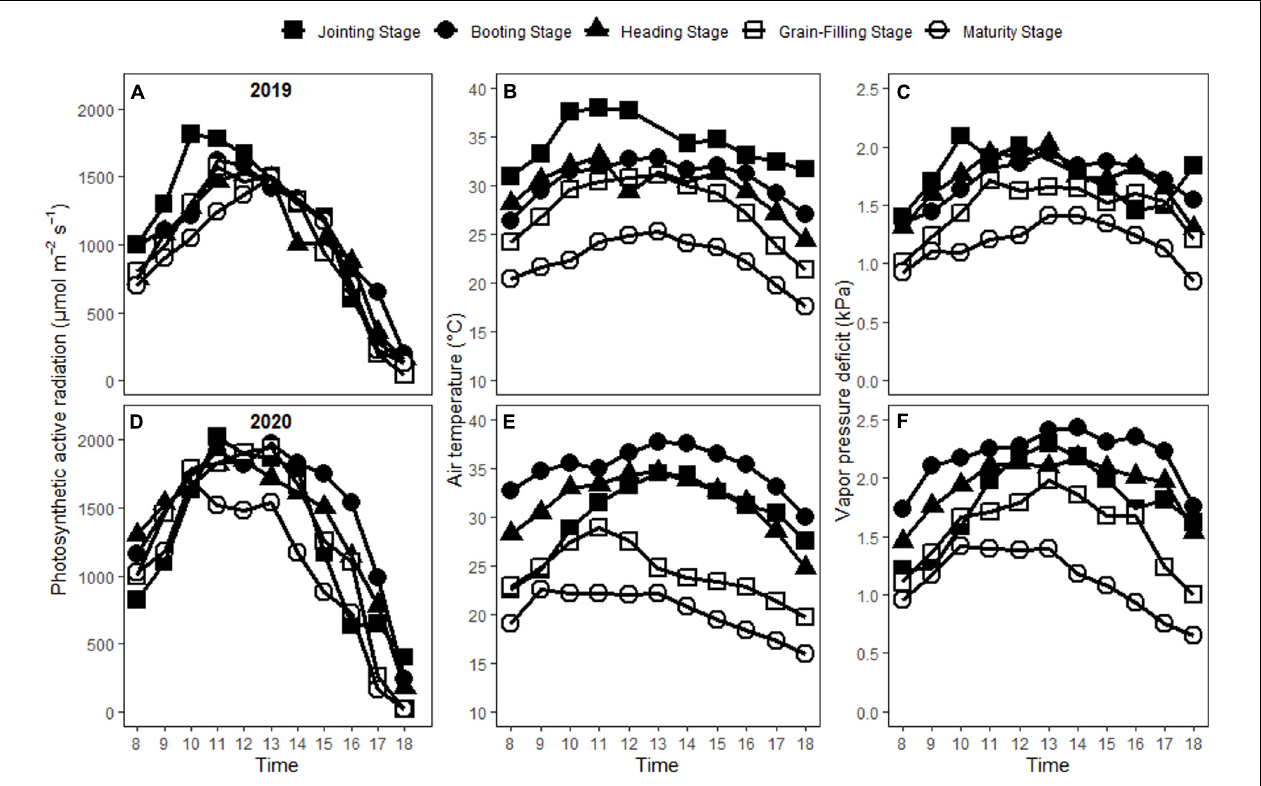
FIGURE 1 | Changes of photosynthetic active radiation (A,D) , air temperature (B,E), and vapor pressure deficit (C,F) with time on the measuring date at five different growing stages in 2019 and